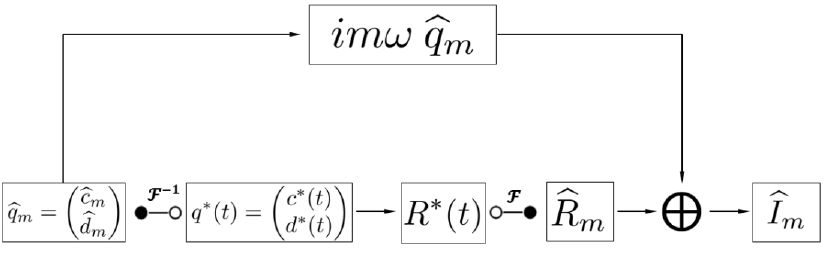
Figure 3. Assembly of parabolic and nonlinear contributions during a hybrid frequency-time-domain approach